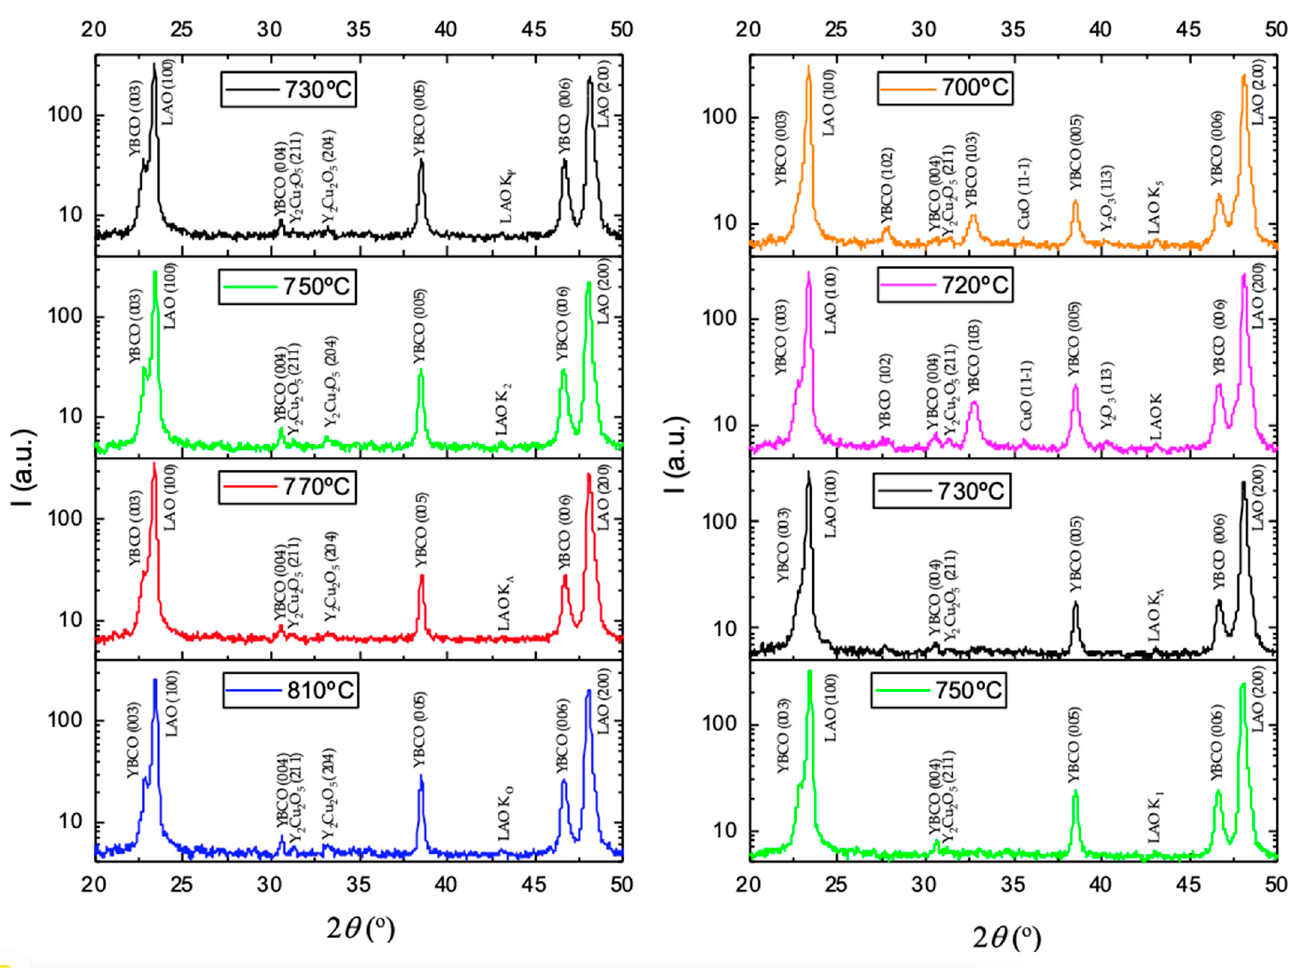
Figure 3. Two-dimensional XRD frames ( χ vs. 2 θ ) from a sample grown at 750 °C with the CTA method ( left ) and 700 °C with the FH method ( right ).